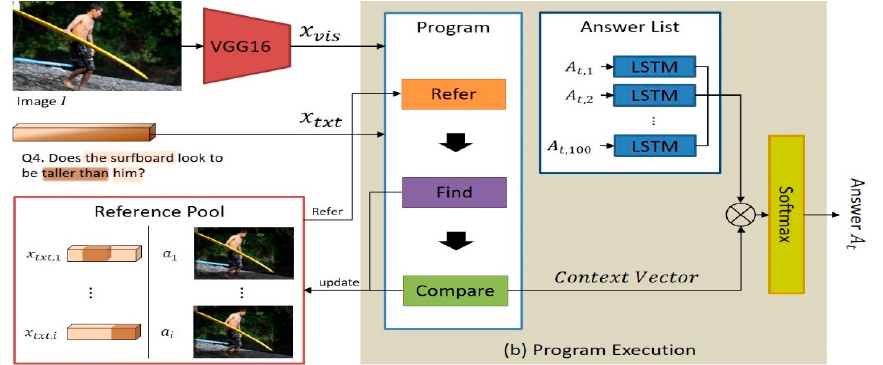
Figure 4. Program execution.